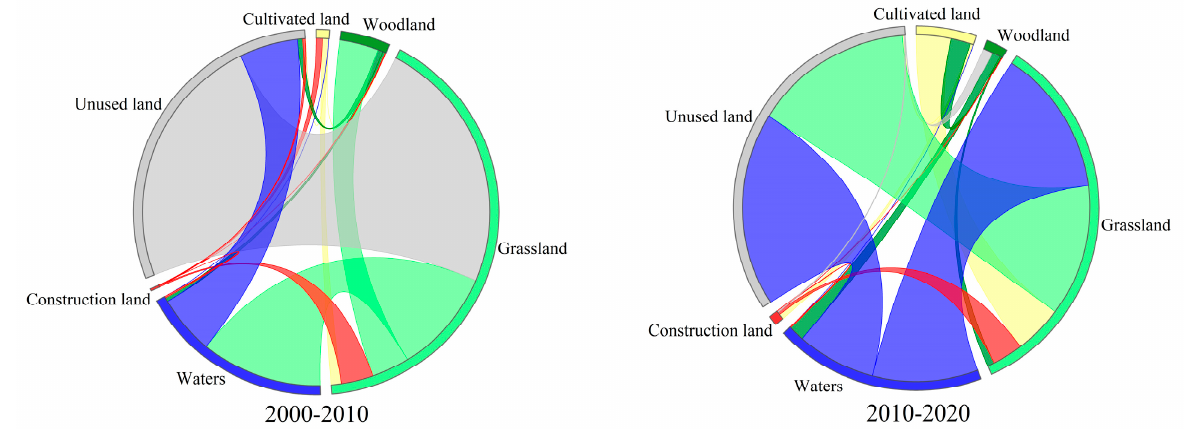
Figure 3. Land use and cover change (LUCC) in the Qinghai Lake Basin from 2000 to 2020 in a chord diagram.